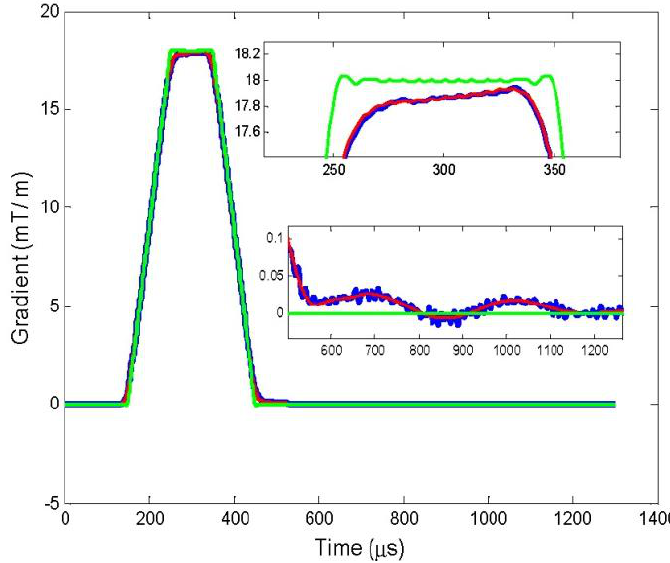
Figure 4. Requested (green), predicted (red) and experimental trapezoidal gradient waveforms for a y gradient with 100 μs rise, top, and fall times, and slew rate of 180 mT/m/ms. The zoomed insets show significant discrepancies between the requested and experimentally measured gradient. Despite the noise on the experimental gradient measurement, it is clear that the GIRF prediction provides a highly accurate description of the actual gradient